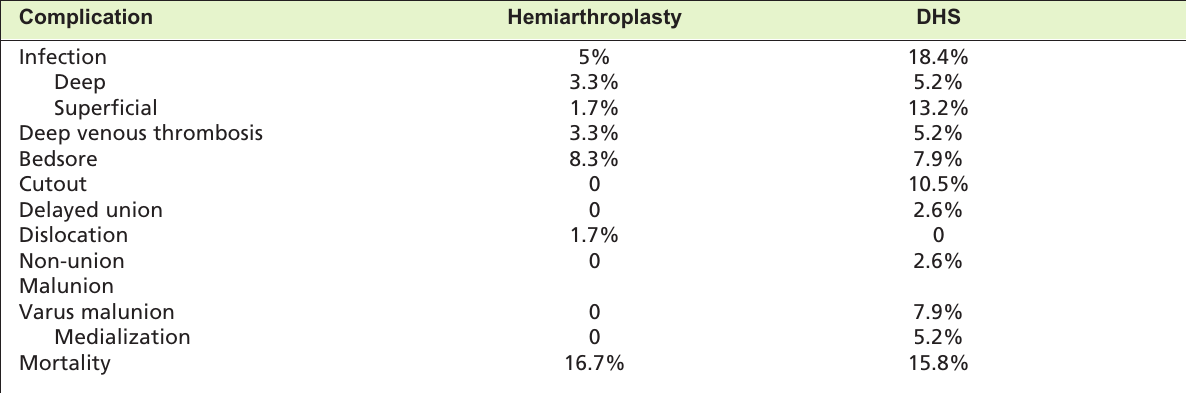
Clinical and mechanical complications in the two Table II: